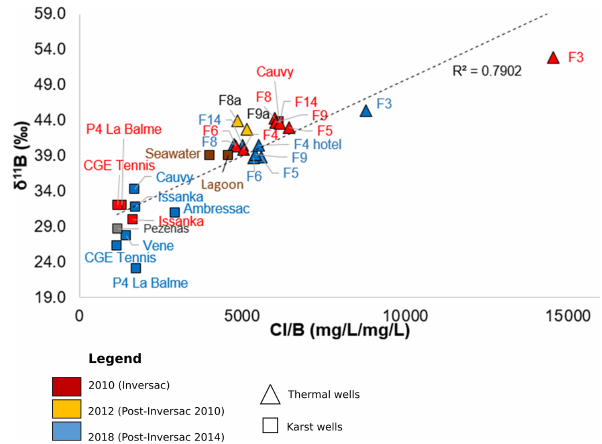
Figure 9. Plot of the δ 11 B versus Cl / B ratio for different hydro- geological contexts: 2010 (inversac times in red) and 2012 and 2018 (post-inversac times in yellow and